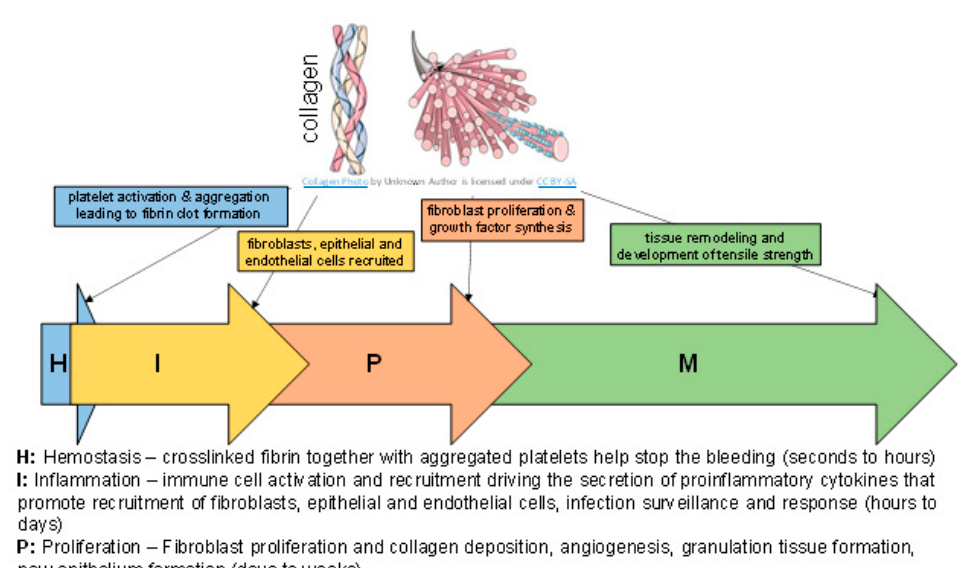
Figure 1. Brief summary of wound healing phases.